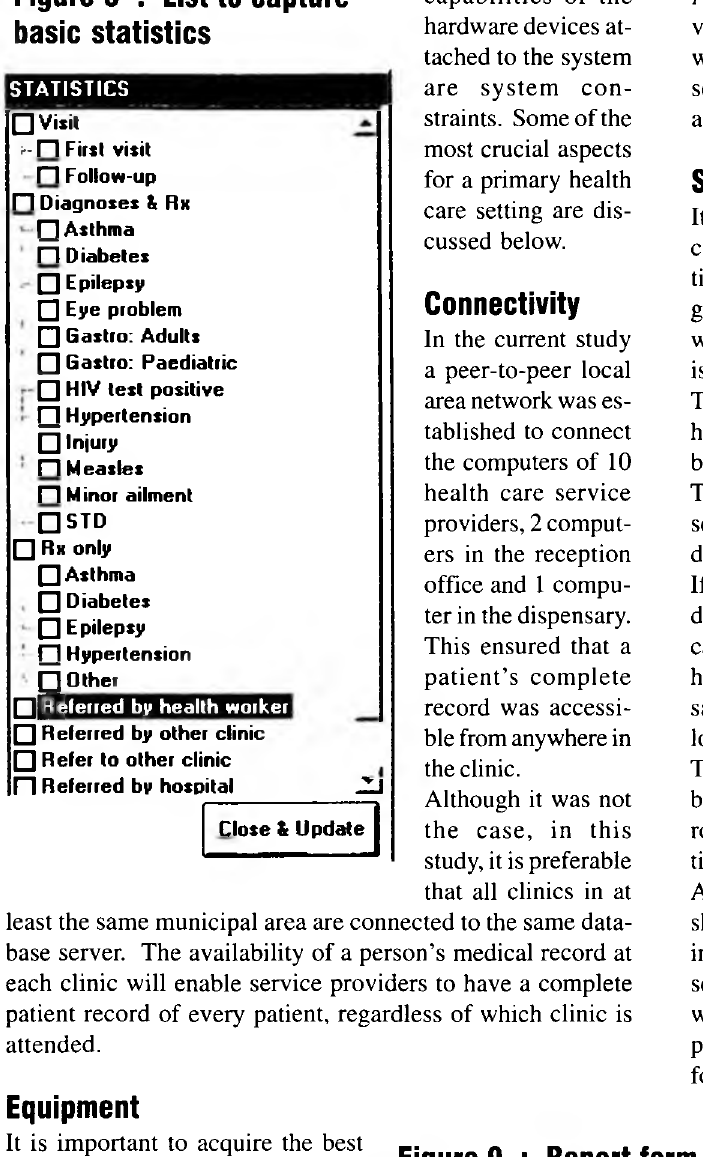
Figure 8 : List to capture basic